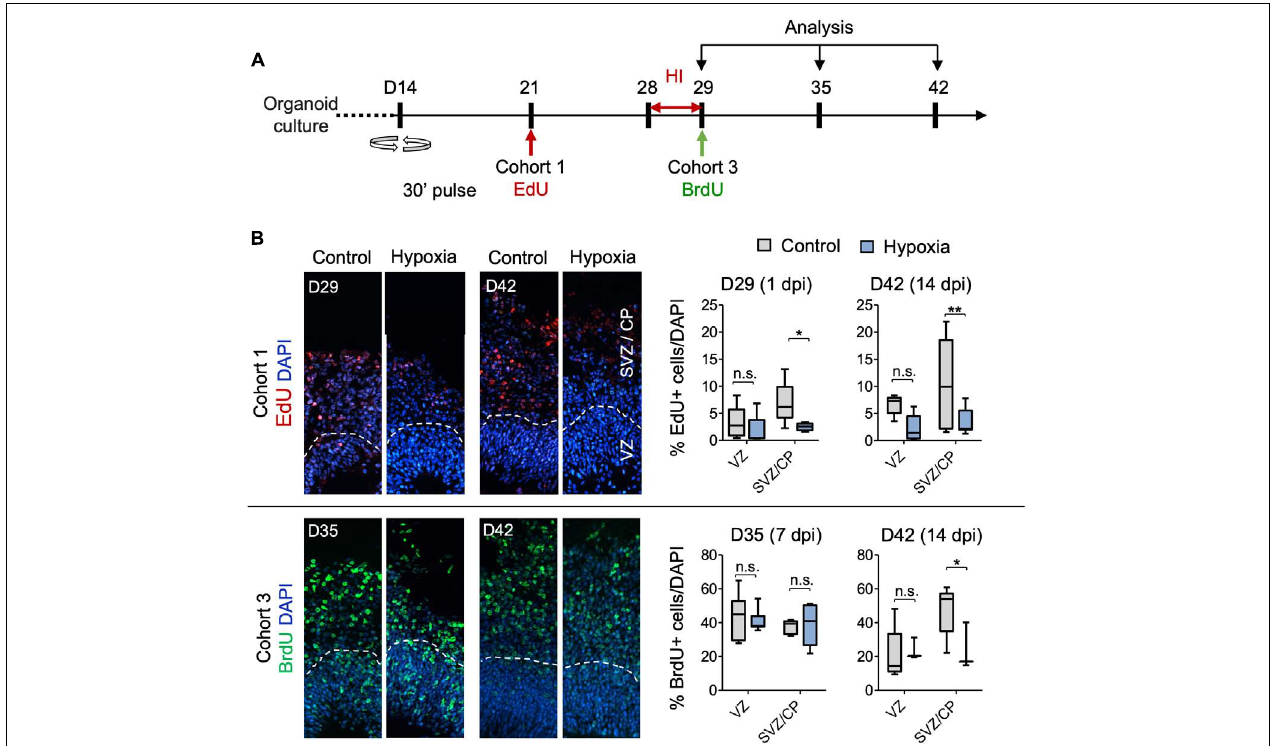
FIGURE 5 | Analysis of isochronic progenitor cohorts reveals vulnerable window and developmental stages affected by HI. (A) Timeline of experimental paradigm to analyze different isochronic cohorts (cohort 1 and 3) of neural precursors and their progeny that are birth-dated at different time points relative to transient HI using 30 min EdU or BrdU pulses followed by chase periods until analysis. (B) Left: Representative fluorescence images show abundance and spatial distribution of BrdU or EdU LRCs of isochronic cohort 1 or 3 at indicated time points during organoid development in control or after HI. White dashed lines demarcate VZ and SVZ/CP-like layers in 100 × 300 µ m radial cortical columns. Right: Quantifications of BrdU + or EdU + LRCs in VZ or SVZ/CP layers. Two-way ANOVA followed by a Tukey post hoc test; n = 9 independent organoids from three different batches. ∗ p < 0.05; ∗∗ p < 0.01; n.s., not-statistically